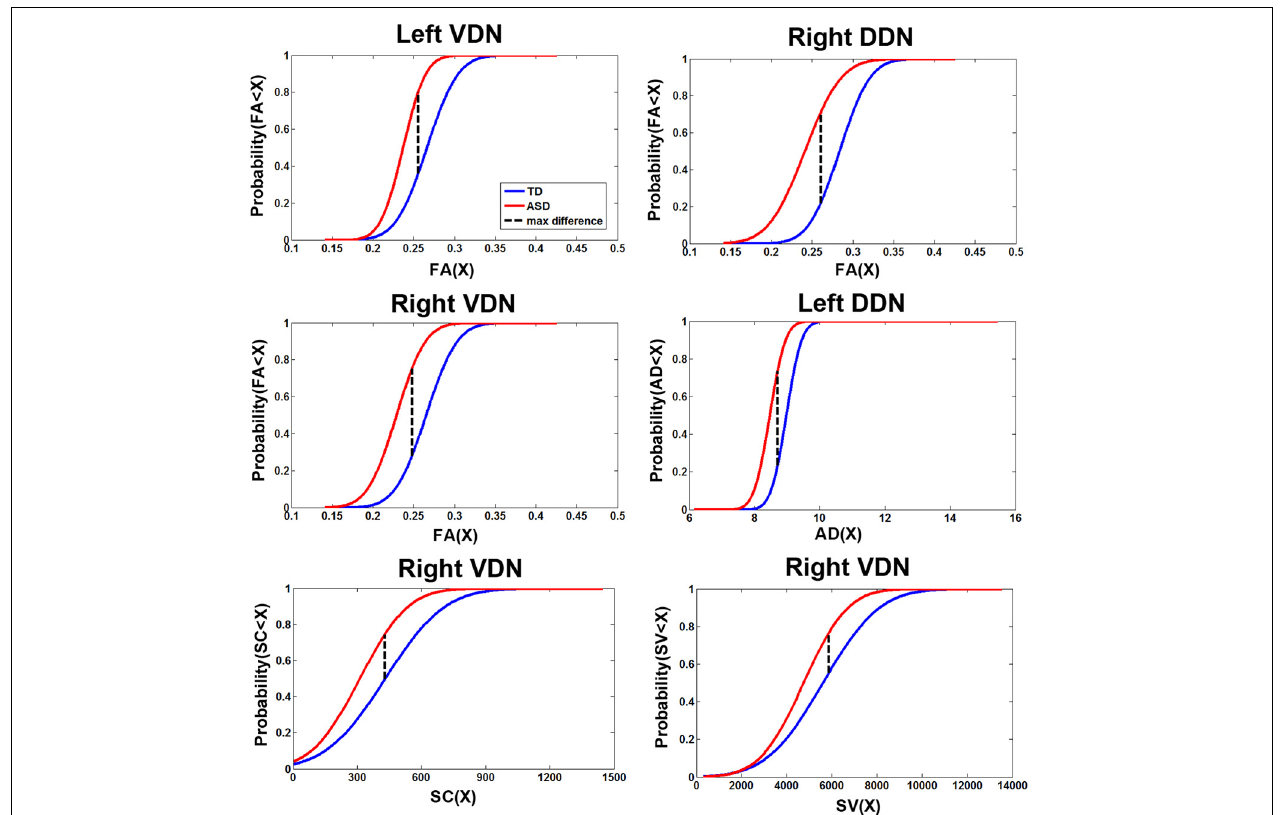
FIGURE 6 | Cumulative density functions of the diffusion parameters showing the significant group differences reported in Figure 5A. Probabilities (parameter ≤ X) were measured from the TD ( n = 14) and ASD